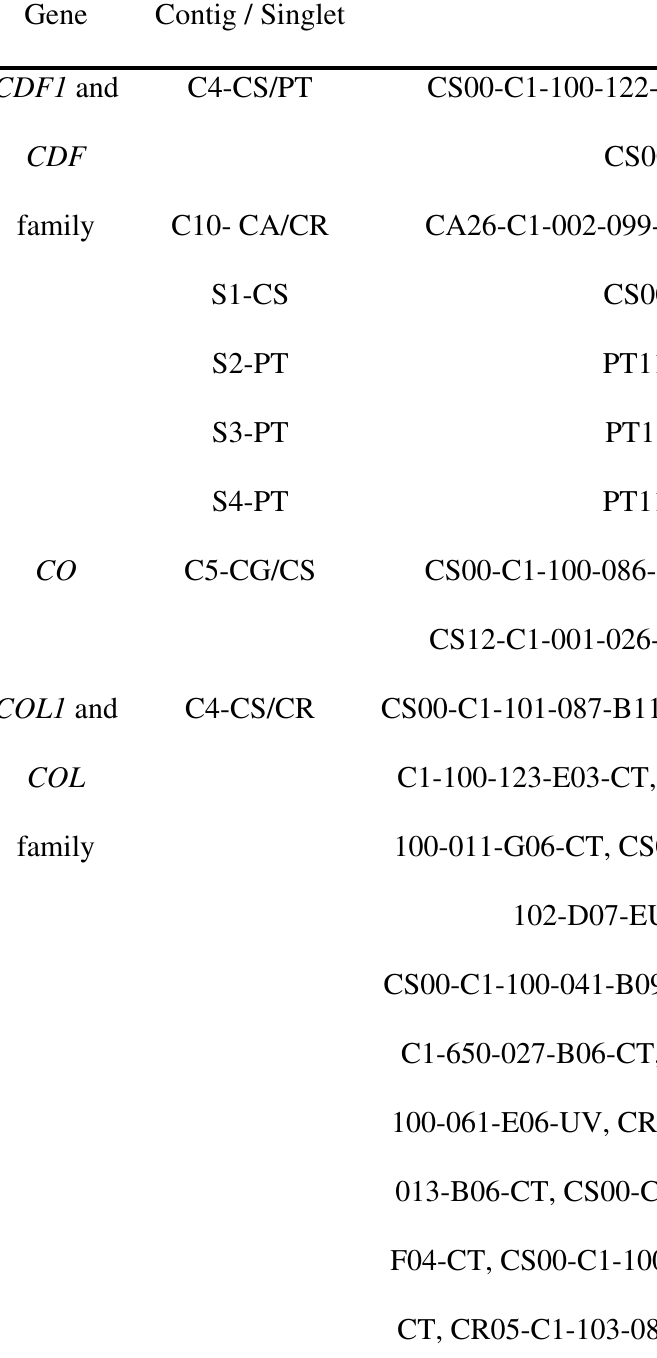
Table 3S - Citrus reads constituting contigs and singlets with homology to genes involved in the integration of the circadian clock mechanism and the generation of output responses Arabidopsis thaliana